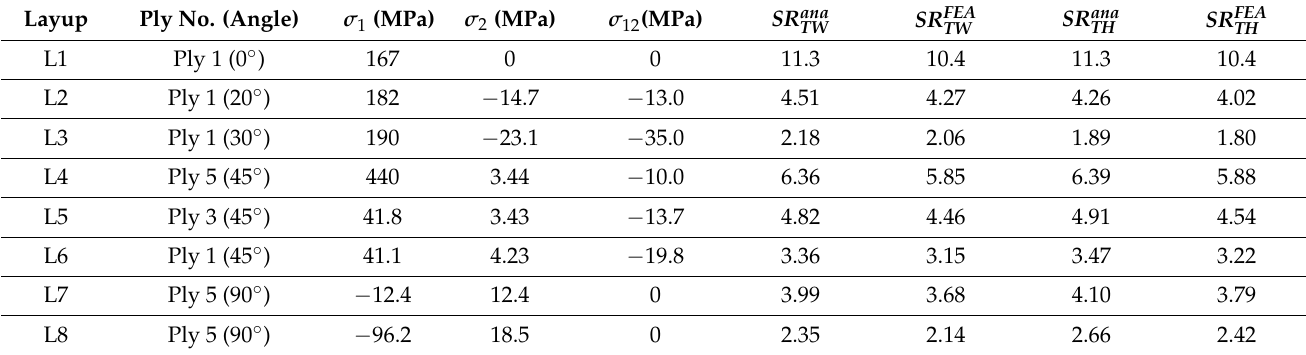
Table A1. Comparison of plies with minimum safety ratios (SRs) for the “SSS” beam (flange under tension; stress values are in MPa); see Figure 3c for a laminate stacking sequence sample.